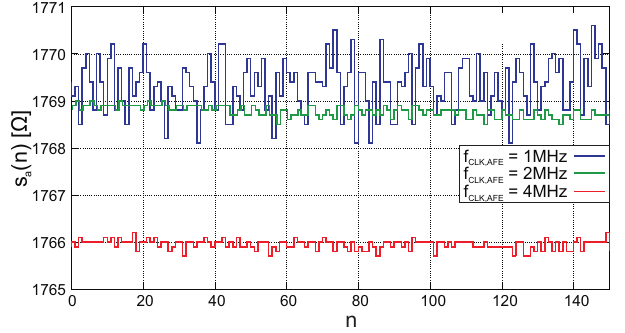
Fig.10: Measured signal s a ( n ) of a 1 . 8k Ω resistance at f s = 64Hz, f s = 24kHz and varying clock frequencies f CLK , AFE